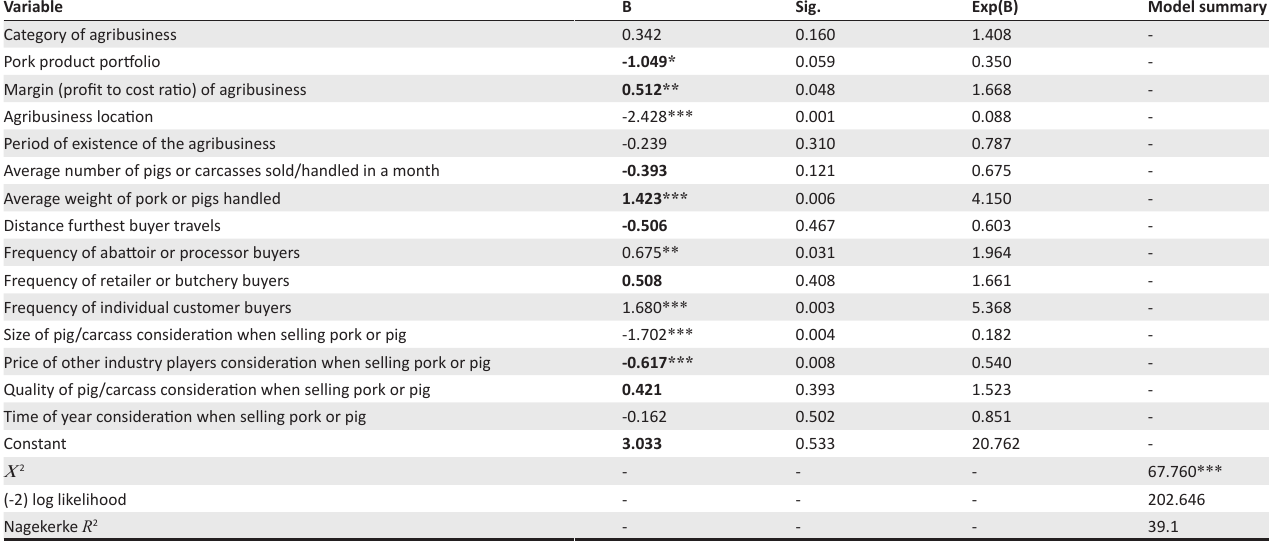
TABLE 7: Empirical binary logistic results of choice of price flexibility policy.